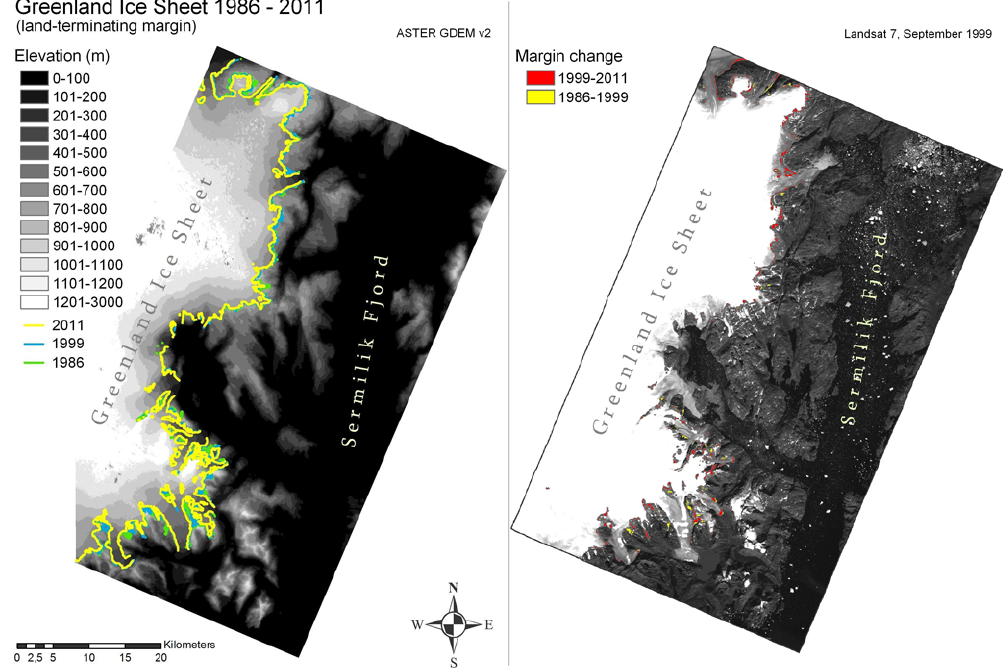
Fig. 7. The location of the GrIS land-terminating margin for the survey years 1986 (green), 1999 (blue), and 2011 (yellow) in the Ammassalik region, and the marginal changes between the survey years. The topography has black and gray shaded colors (source: ASTER GDEM v2 and Landsat 7).